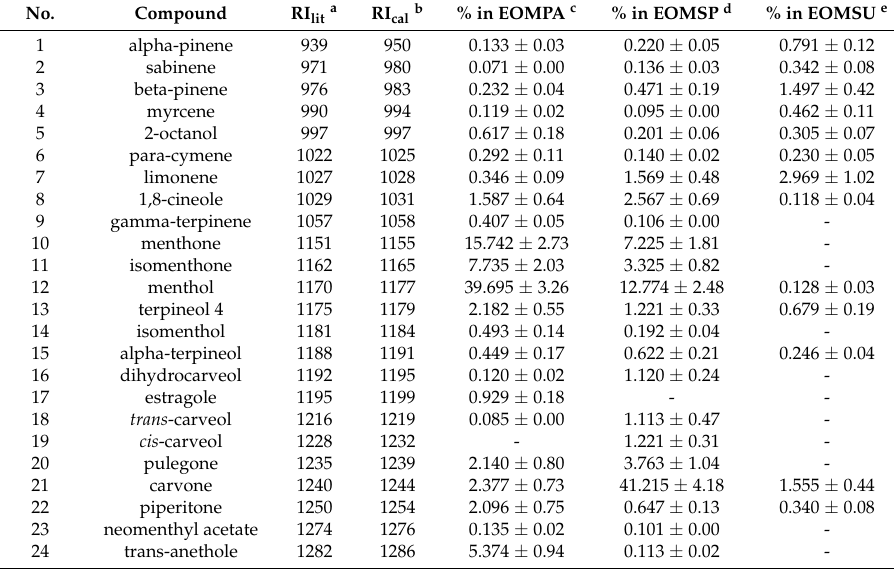
Table 1. Chemical composition of the essential oils from the selected Mentha